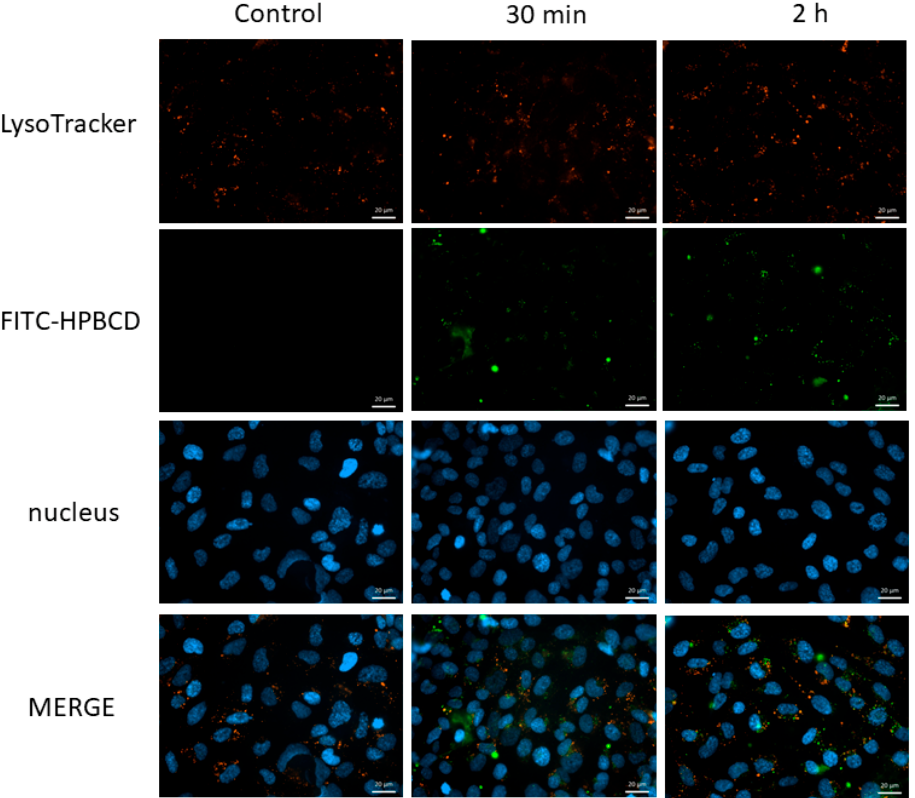
Figure 10. Fluorescence microscopic images of FITC-HPBCD containing intracellular vesicles and lysosomes in hCMEC/D3 cells after 30 min and 2 h of incubation. Blue: cell nuclei, green: FITC- HPBCD, red: lysosomes stained with Lysotracker, yellow pixels: colocalization of FITC-HPBCD and lysosomes. Bar: 20 µm.